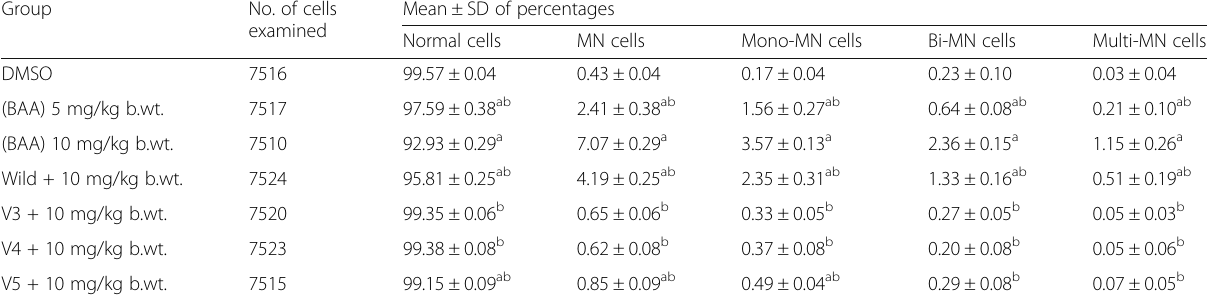
Table 3 The effect of (BAA) or its residues after biodegradation by different types of bacteria on the induction of MN. Showing MN cells: total cells with MN, Mono-MN cells: with one MN, Bi-MN cells: with two MN, Multi-MN cells: with more than two MN. p < 0.05) Group